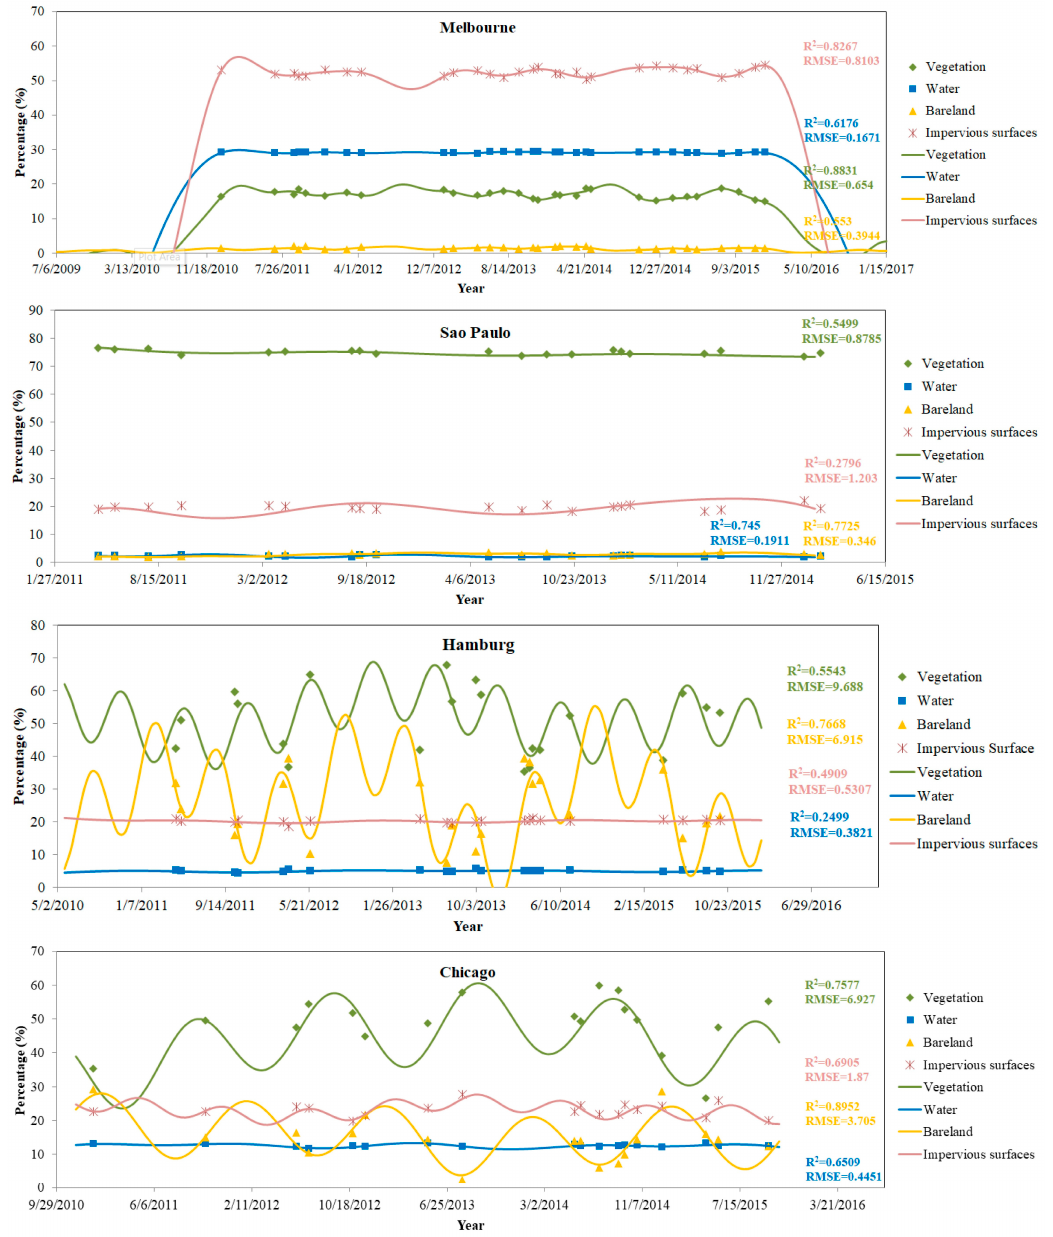
Figure 7. Temporal variations of different urban land cover types fitted using the Sum of Sine Functions.